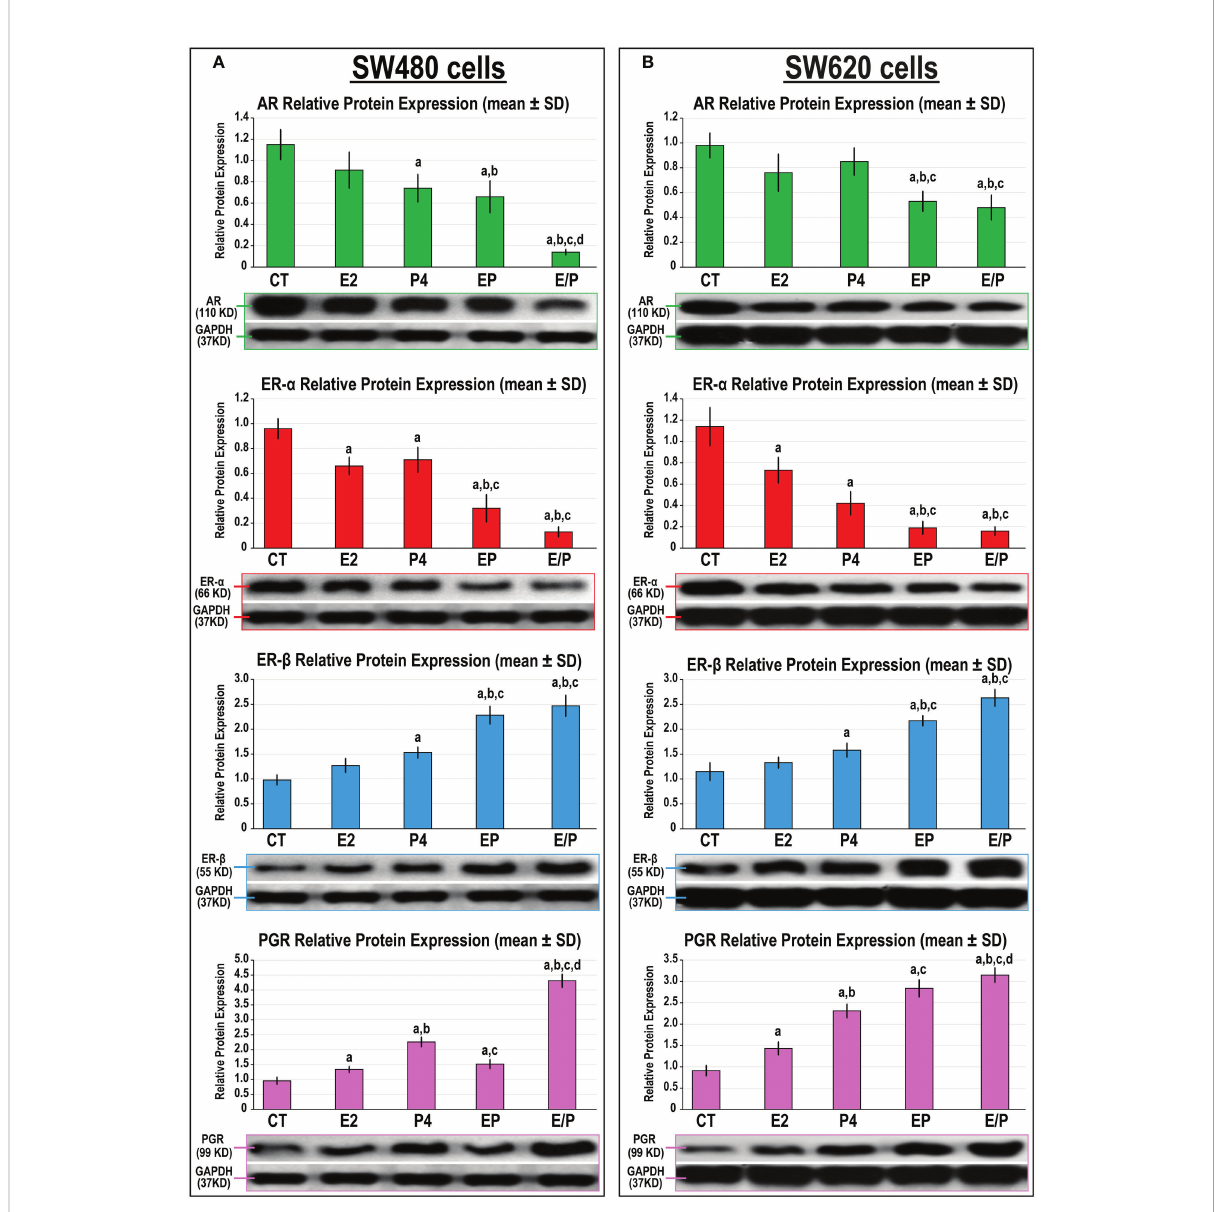
FIGURE 9 Detection of androgen (AR), progesterone (PGR) and oestrogen (ER) a and b receptors by Western blot alongside their relative protein expression (mean ± SD) following the different treatment protocols with E2 and/or P4 for 48 hours in the (A) SW480 and (B) SW620 male colon cancer cell lines (mean ± SD; a P< 0.05 compared with the CT group; b P< 0.05 compared with the E2 monotherapy group; c P< 0.05 compared with P4 monotherapy and d P< 0.05 compared with EP concurrent dual therapy